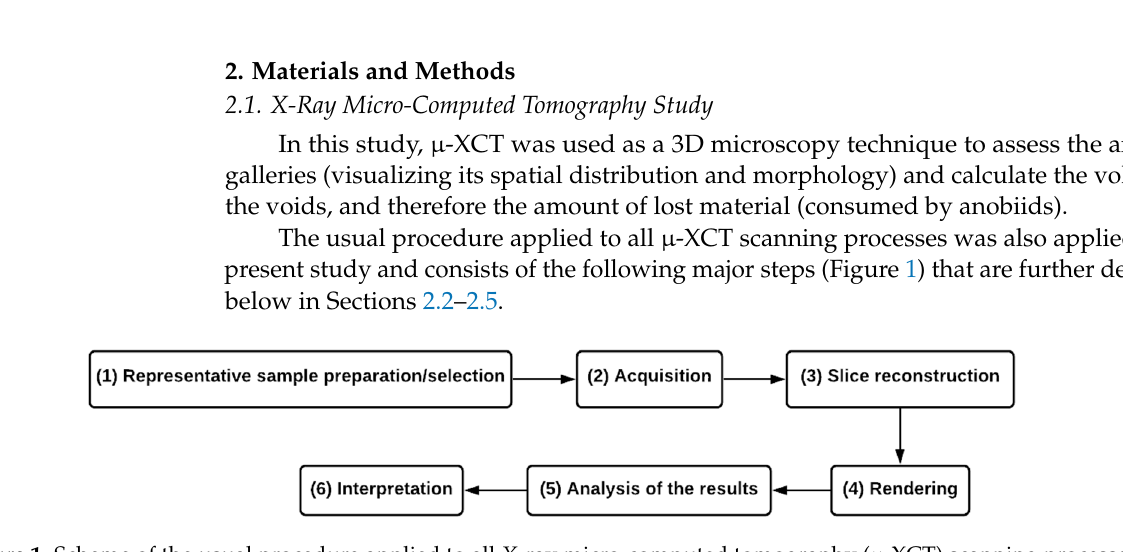
Figure 1. Scheme of the usual procedure applied to all X -ray micro-computed tomography ( µ -XCT) scanning processes.